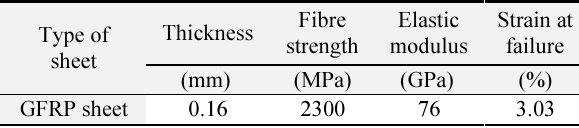
Table 4. Specifications of FRP